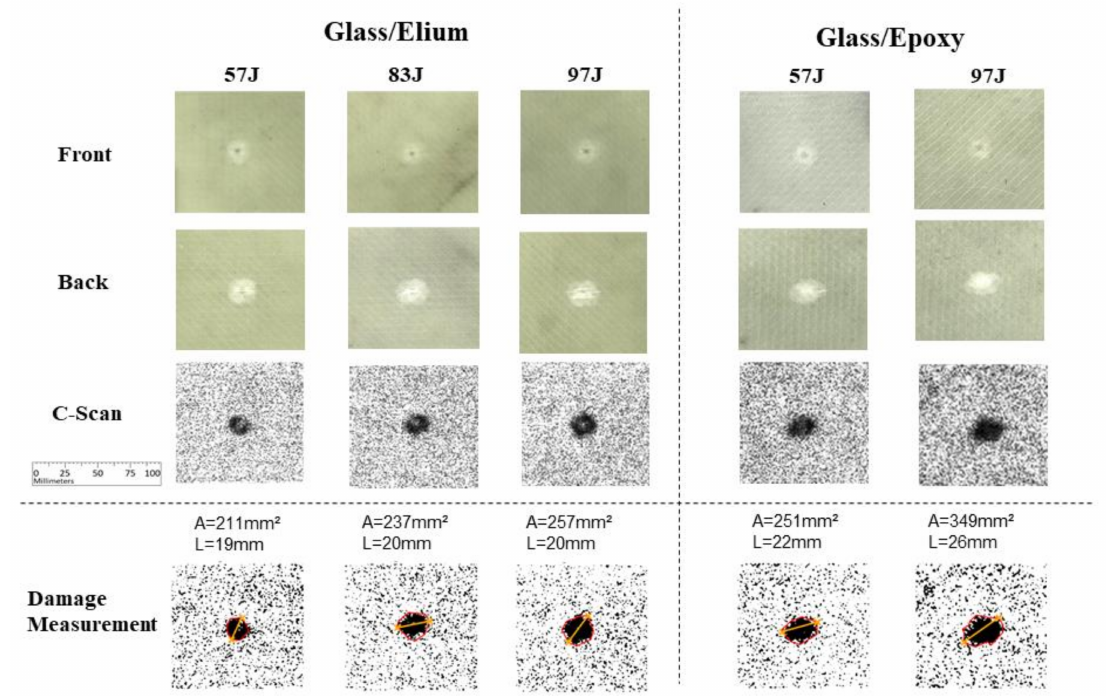
Figure 14. Experimental results for glass fiber